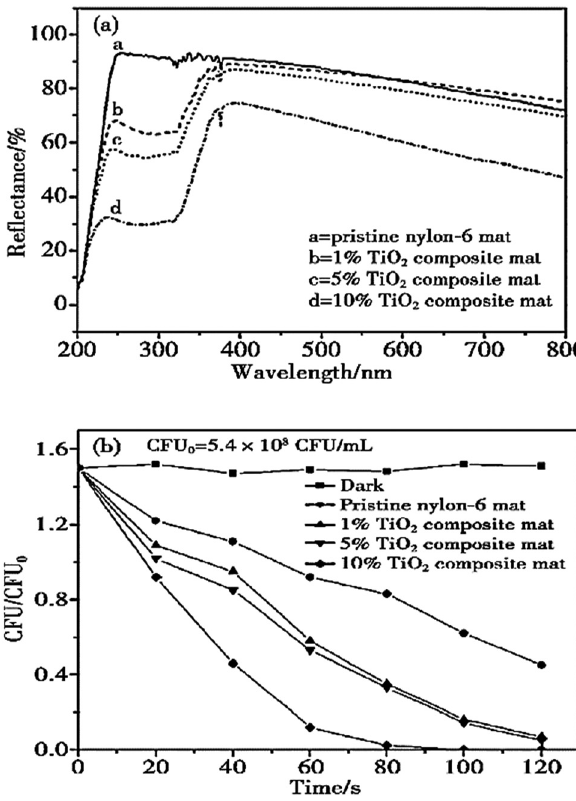
Figure 7: ( a ) UV - visible spectra of pristine nylon - 6 and di ff erent nylon - 6/TiO 2 nanocomposite mats. ( b ) Antimicrobial e ffi ciency of pristine nylon - 6 and di ff erent nylon - 6/TiO 2 nanocomposite mats ( 85 ) . Copyright 2011,